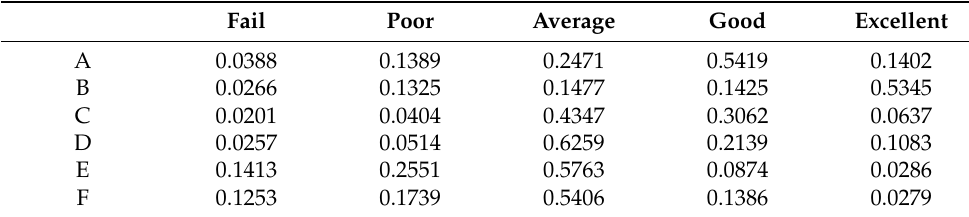
Table 6. Comprehensive evaluation of each electric bus.